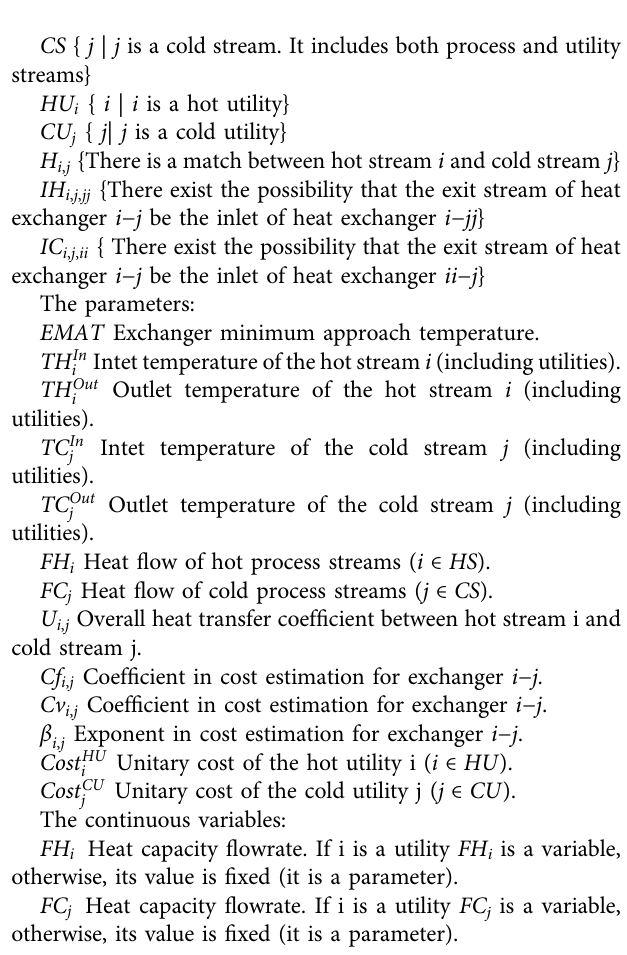
FIGURE 3 | Scheme of the superstructure for the HENDesign model. The fi gure represents the case in which a hot stream i can exchange heat with two cold streams j and jj. And a cold stream j can exchange heat with two hot streams i and ii.